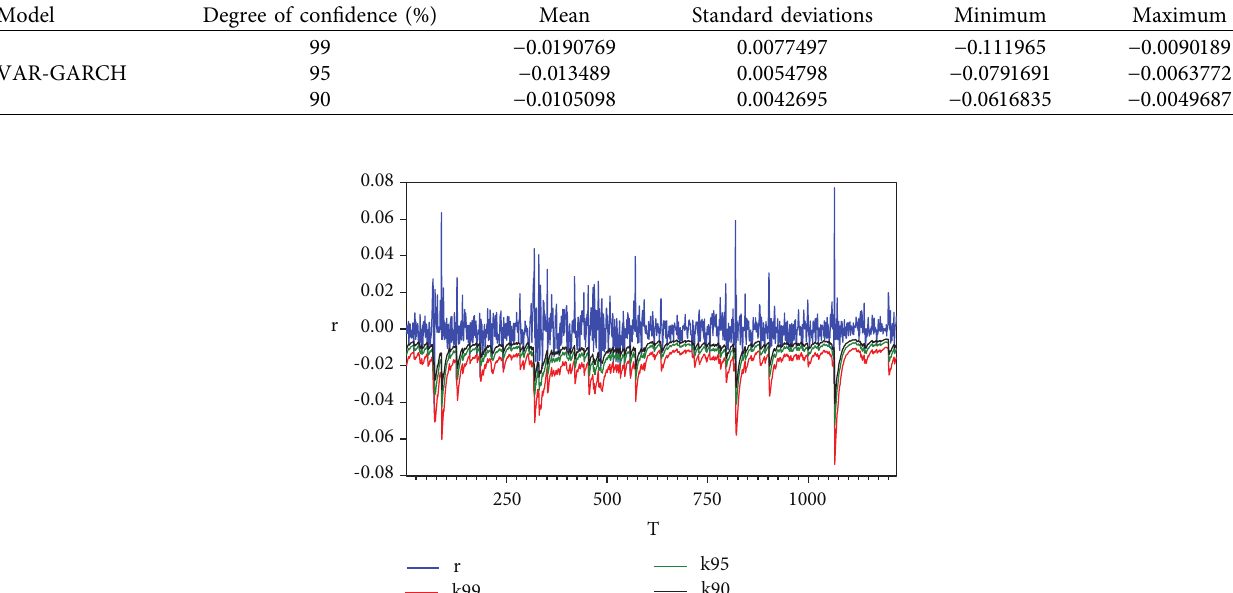
Table 8: Risk value calculation of the two models at different confidence levels.